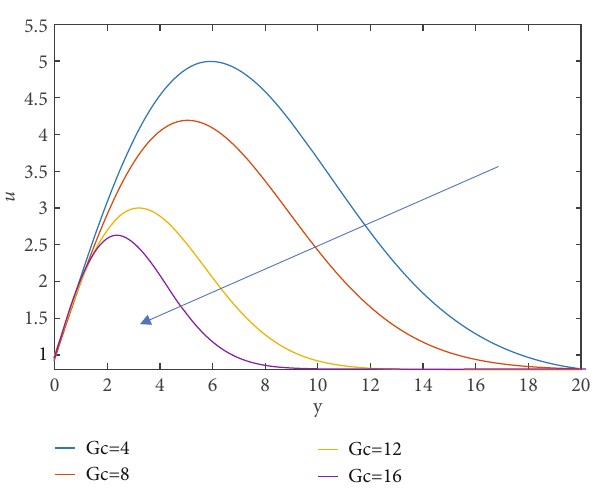
Figure 12: Distinct values of Gc for velocity fi eld when M = 2 , t = 2 , Kc = 1 : 5 , k = 1 , Gr = 5 , Ec = 0 : 1 , F = 1 , Sc = 2 : 01 , m = 1 , H = 2 , ⋋ = 1 , and Pr = 6 : 2 .